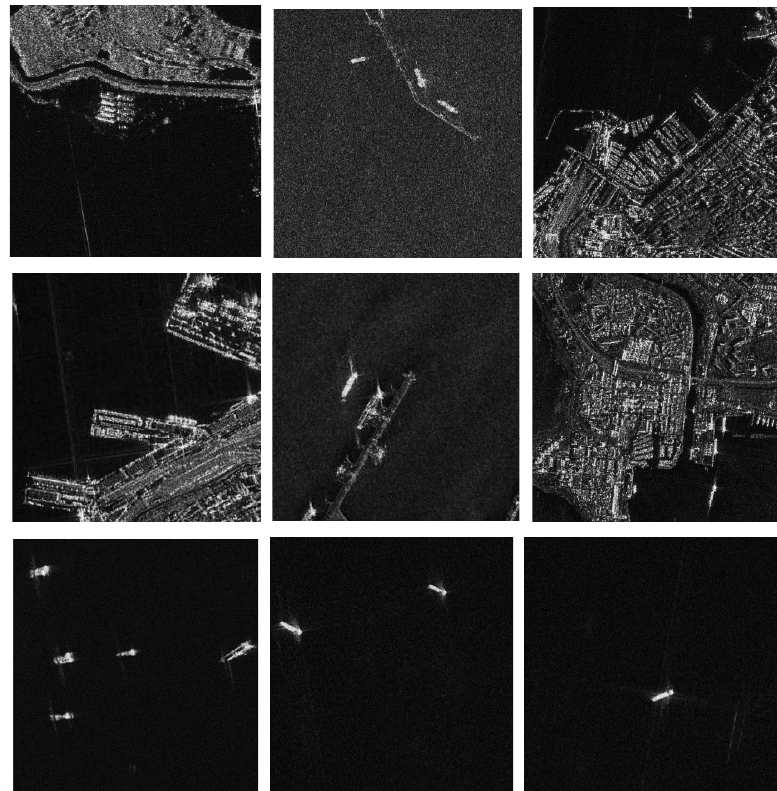
Figure 9. The ship target images in the AIR-SARship 1.0 dataset.